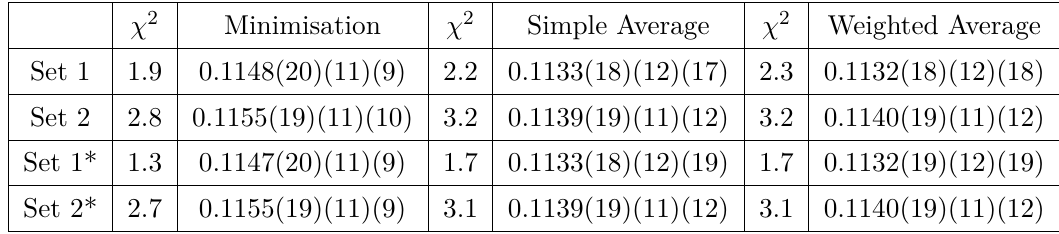
Table 6 . Averaged results for α ( n f =5) s ( M 2 variations are assumed to be uncorrelated.